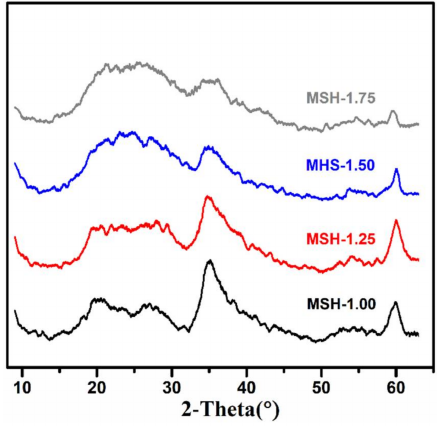
Figure 1. X-ray Diffraction (XRD) patterns of magnesium silicate hydrate samples (MSH) with different Si/Mg feeding ratios from 1.00 to 1.75.